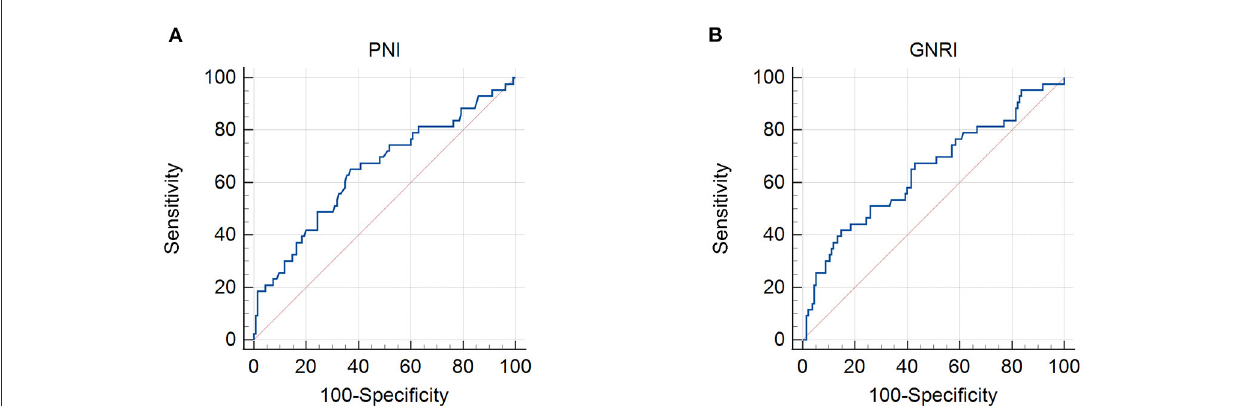
FIGURE1 Receiver operating characteristic curves for the use of nutritional indicators to predict life expectancy in patients with stage IIB–III cervical cancer receiving radiotherapy based on: (A) prognostic nutritional index (PNI) and (B) geriatric nutritional risk index (GNRI). Cut-off points with the highest combined sensitivity and specificity were used.